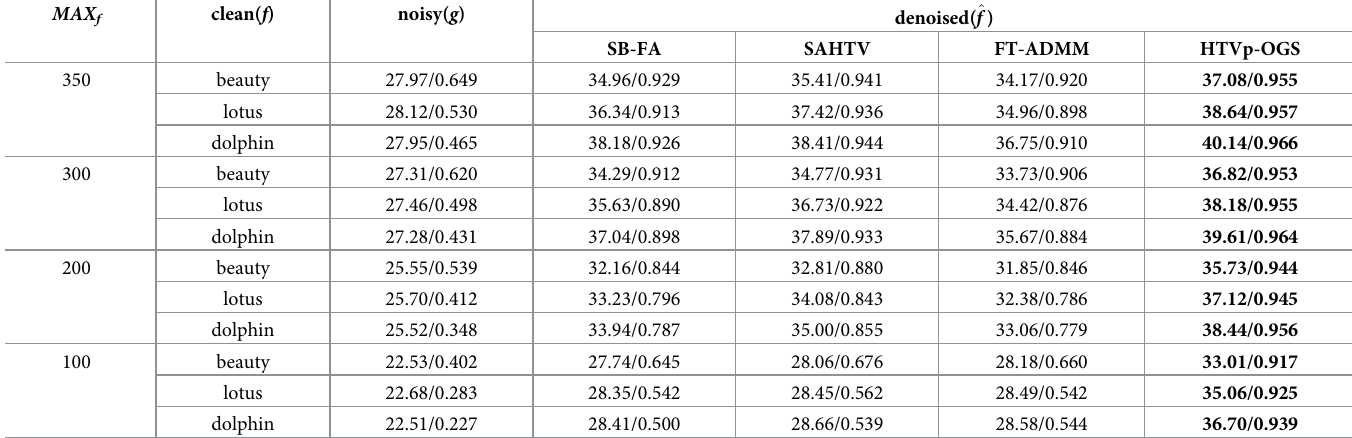
Table 1. The PSNR and SSIM values for denoised images by different methods.